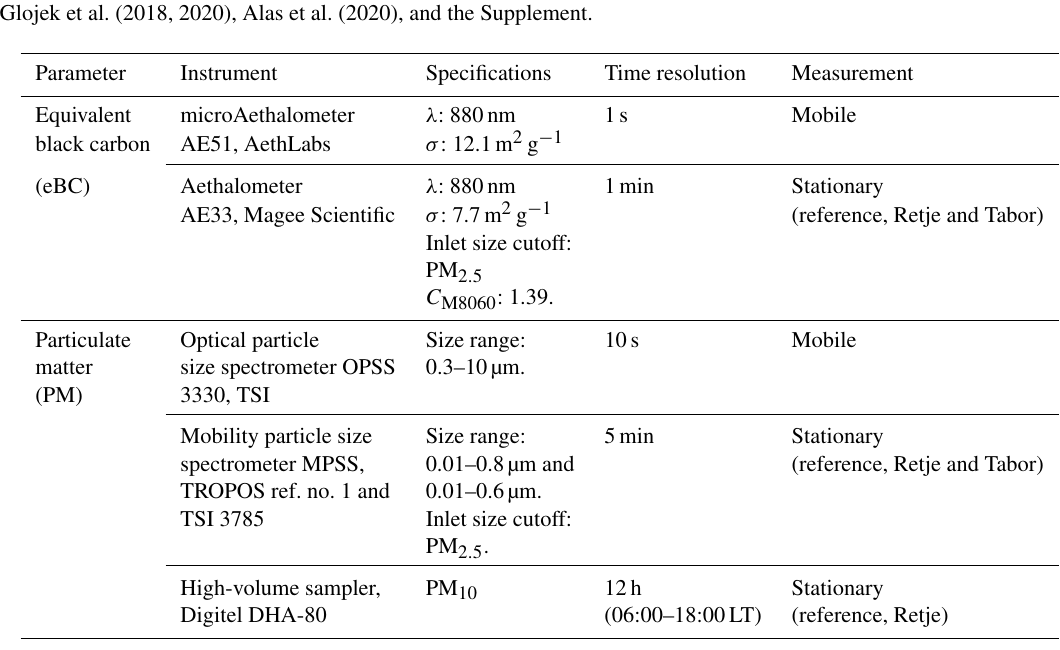
Figure 1. (a) Location of the study site in Europe. (b) Topographic map of the studied area with the marked fixed route and stations. (c) Profile of the terrain across the Retje karst depression with the marked village at its bottom. Table 1. Description of reference and mobile instruments for eBC and PM measurements. Time is reported as local time (LT).